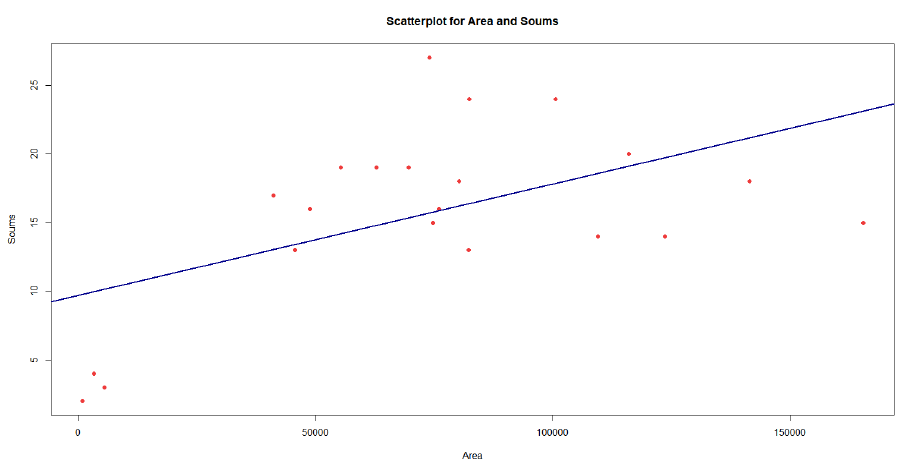
Figure 11. Scatterplot for area and soums. Table 7. Regression between area and number of soums. -